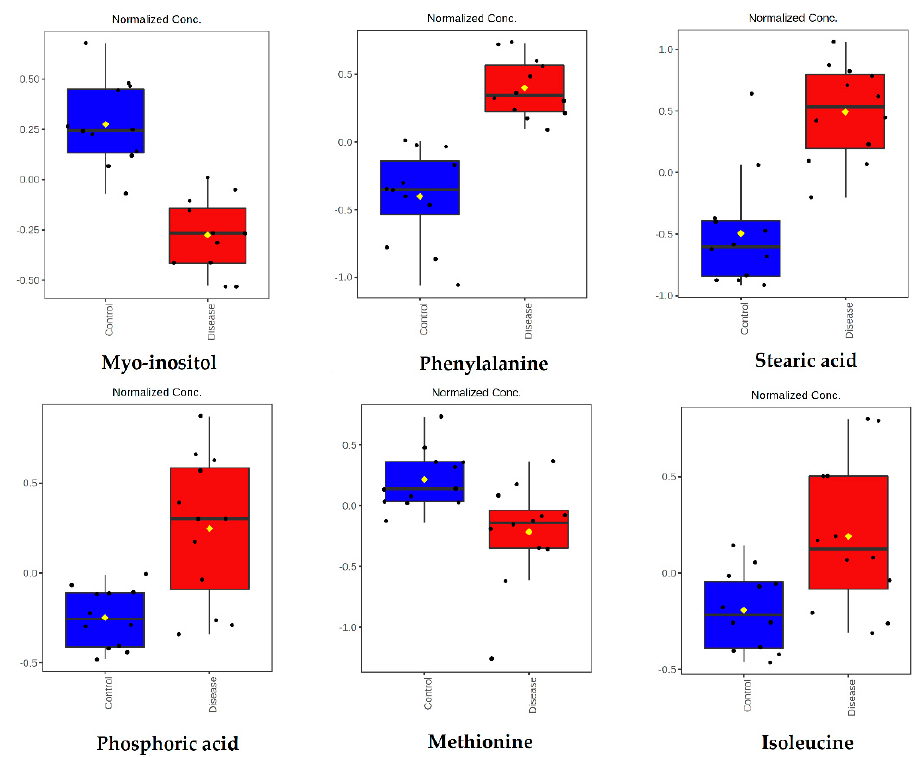
Figure 4. Concentrations of metabolites significantly altered in dogs infected with B. canis and generated by the GC-MS metabolomics approach. Data are presented as box and whiskers plot (mean ± SD). All metabolites shown demonstrated a statistically significant difference between groups by t -test ( p < 0.05). Blue-control samples, red-disease samples.